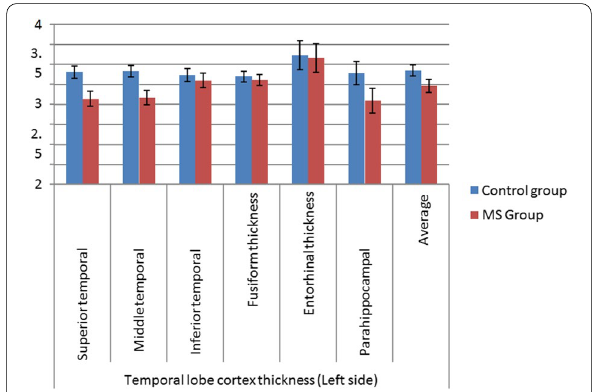
Fig. 4 Comparison between MS and controls according to temporal lobe cortex thickness (right